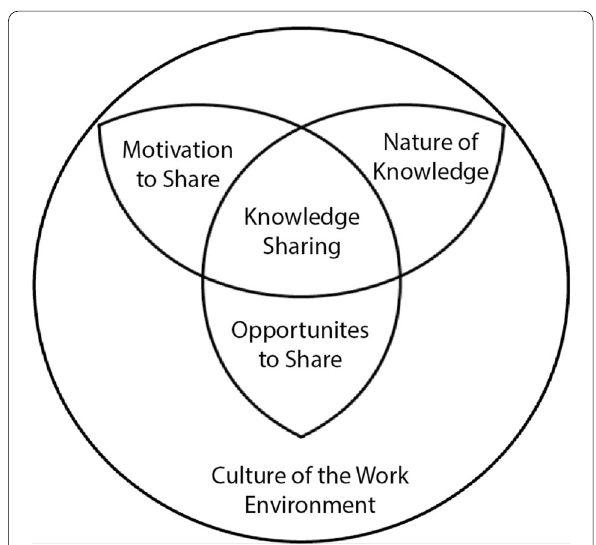
Fig. 1 Knowledge sharing framework adapted from Ipe (2003). This framework focuses on how information is exchanged between individuals within an organization. The diagram shows how the various factors interact with each other to affect knowledge